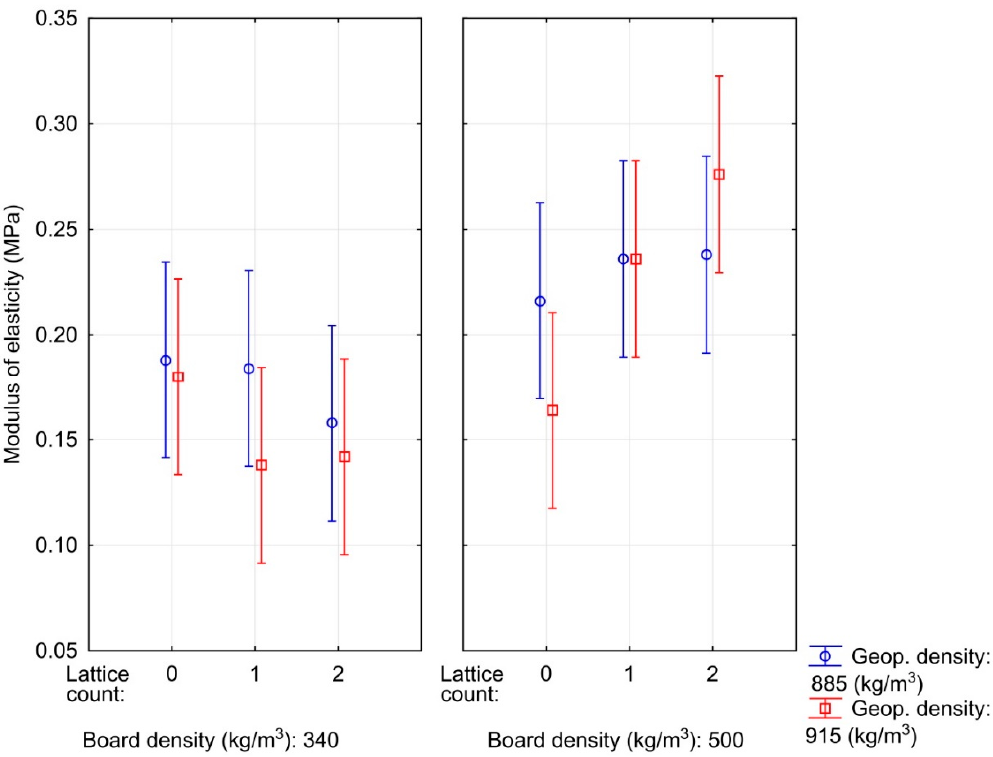
Figure 2. Influence of particleboard density, geopolymer density and the number of lattices on the bending strength of composite materials.